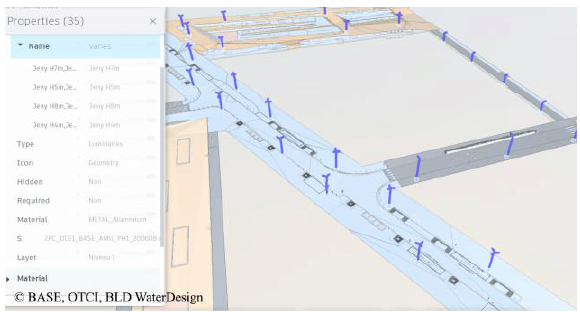
Figure 4 . Number and height of streetlights of the work area